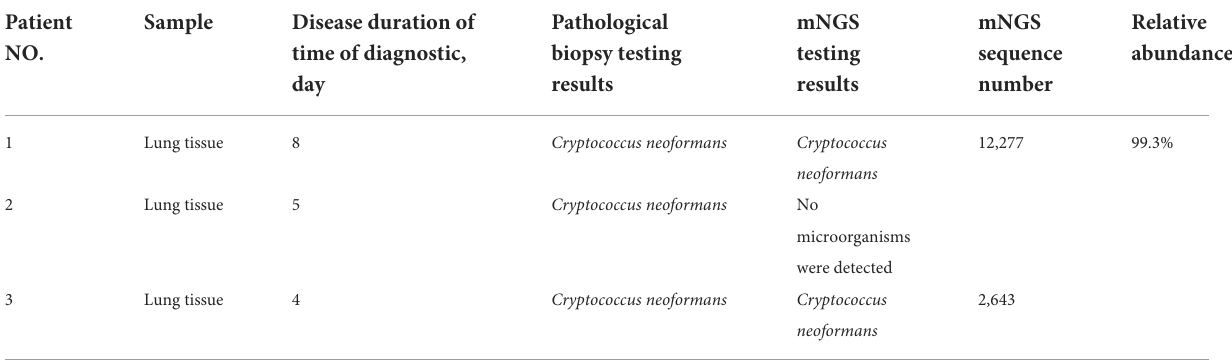
TABLE 2 Summary of Pathological biopsy results and mNGS